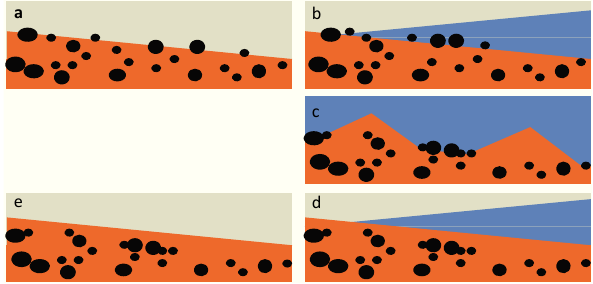
Figure 16. Cartoon illustrating the sequence leading to the surficial fine-grained sediment layer via the development of vortex ripples. Cobbles and stones are black, finer sediments brown. (a) Initial state at low water. (b) Rising tide, larger particles displaced/dislodged by the shore break and swash. (c) Rising tide after passage of the shore break and swash, finer sediments have been gathered into rip- ple crests, leaving a stone and cobble lag in the troughs. (d) Falling tide, ripples planed flat by swash and shore break, creating a veneer of fine sediment. (e) Final state at low water.